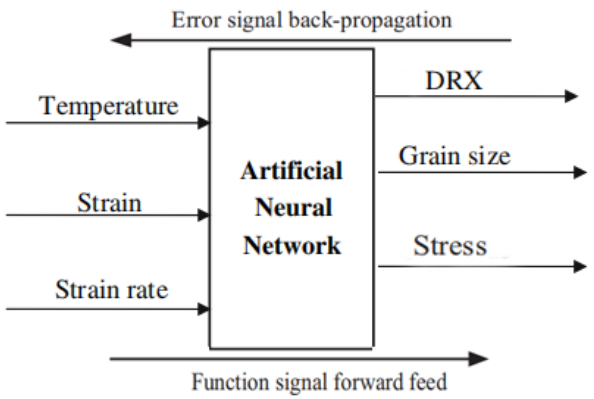
Figure 3. Schematic diagram of the artificial neural network (ANN) operation.